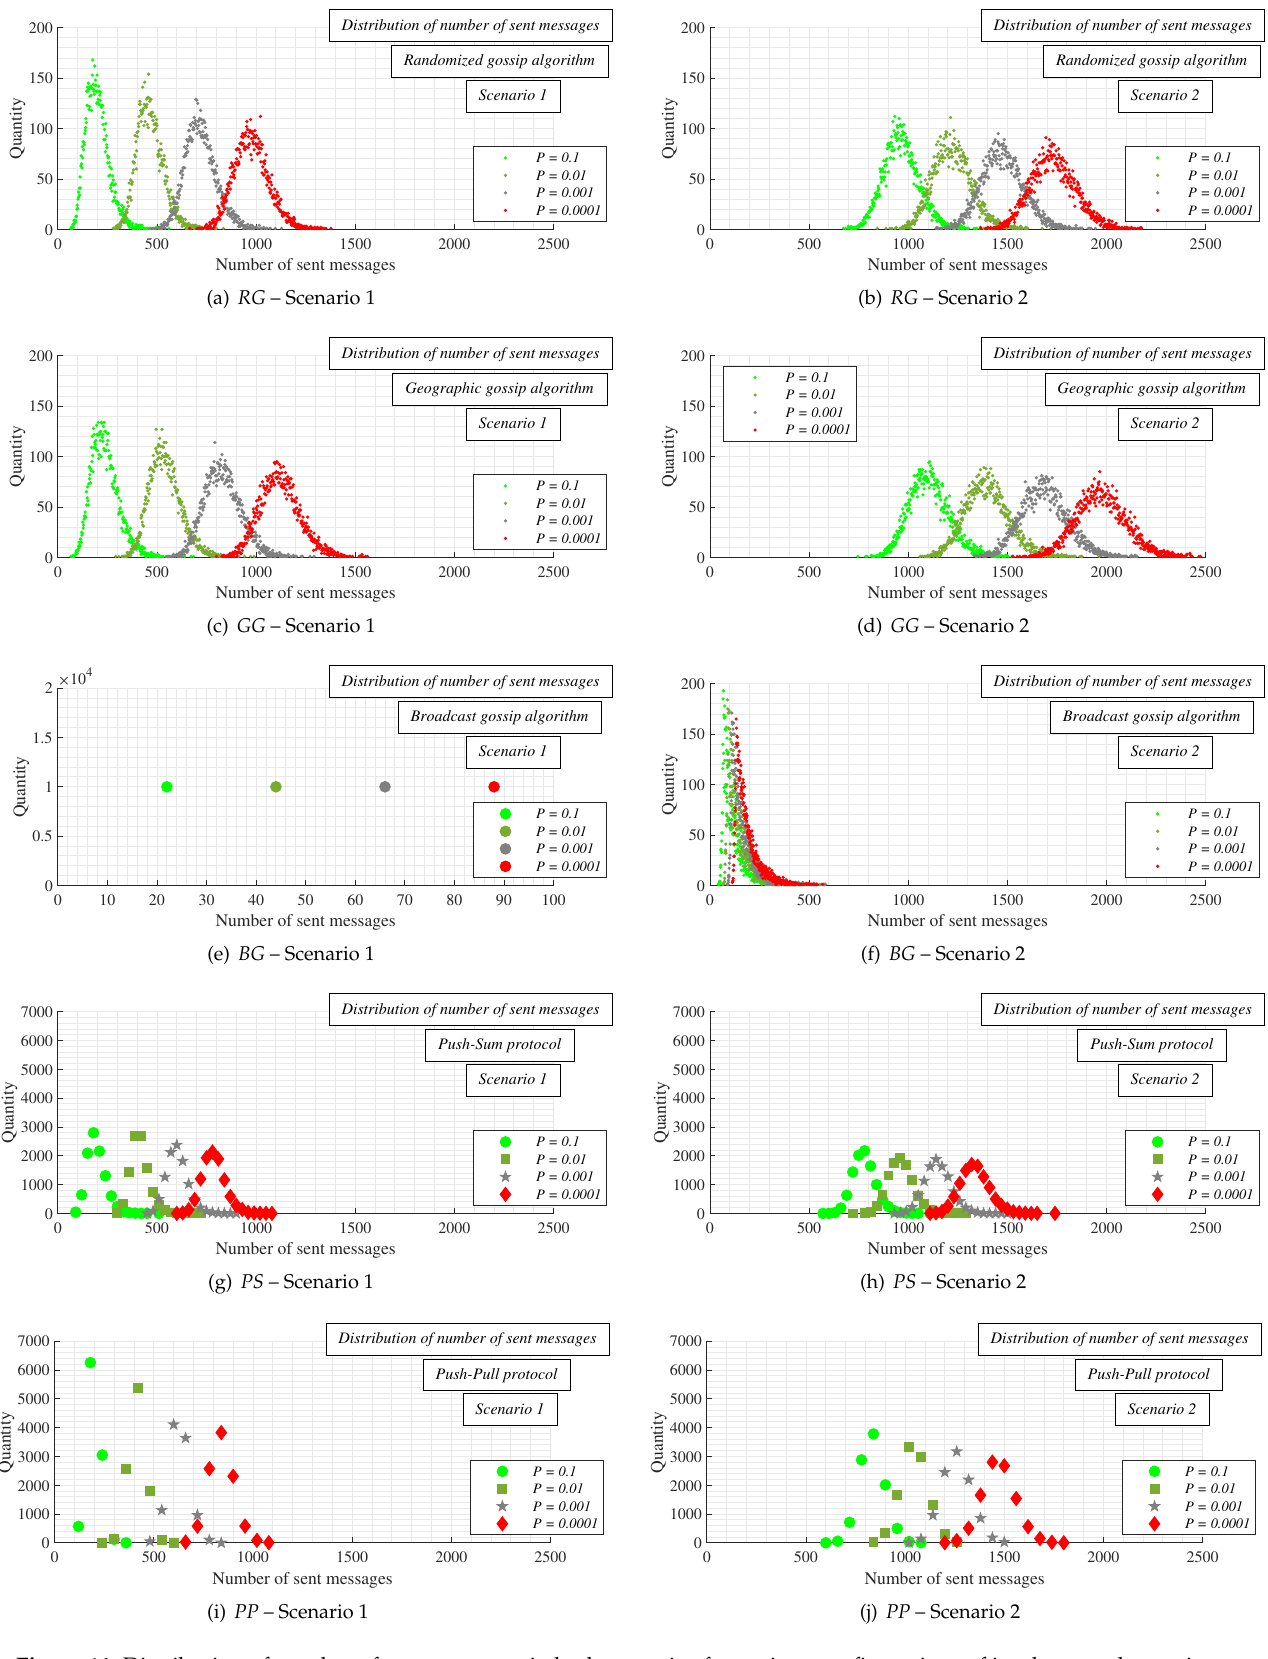
Figure 14. Distribution of number of sent messages in both scenarios for various configurations of implemented stopping criterion and with the best-connected agent as